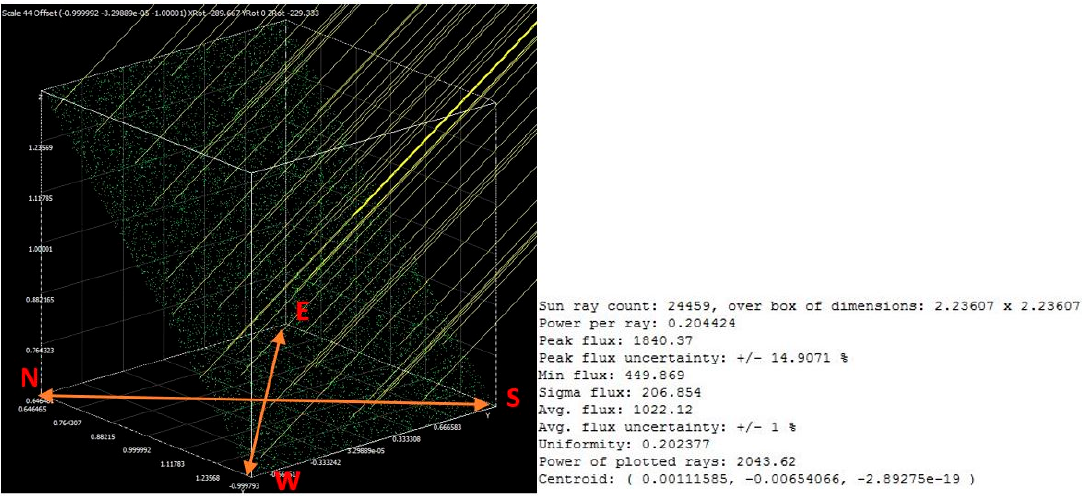
Figure 10. Incident solar radiation on the panel—noon.